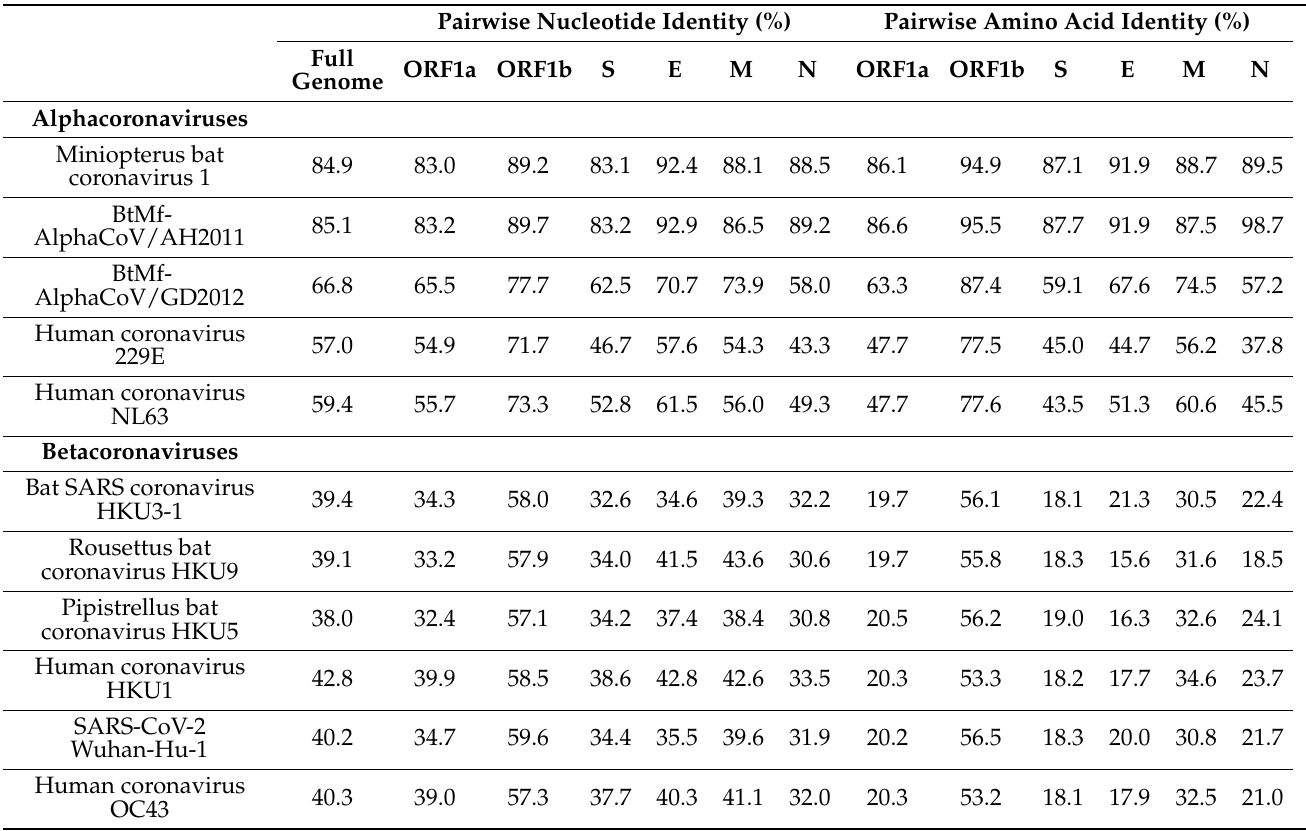
Table 3. Pairwise nucleotide (nt) and amino acid (aa) identities of the novel batCoV/MinFul/ 2018/SriLanka strain compared to selected α -CoVs and β